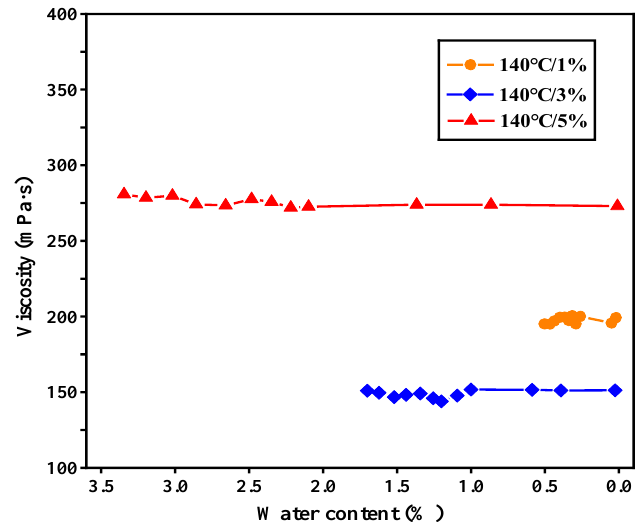
Figure 6. Viscosity versus water content of foamed asphalt.